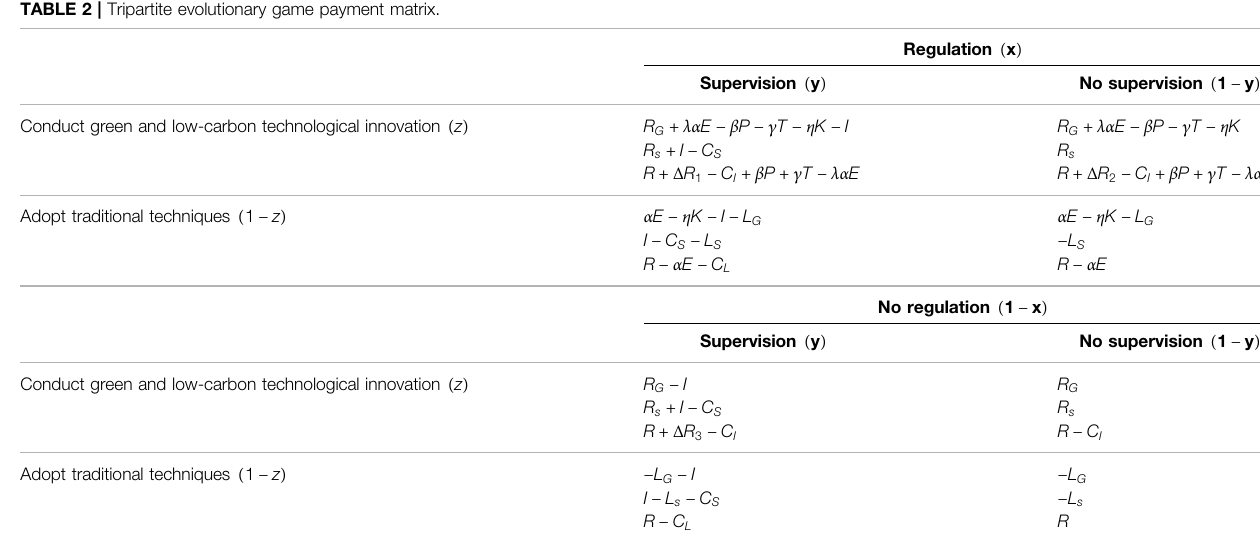
TABLE 2 | Tripartite evolutionary game payment